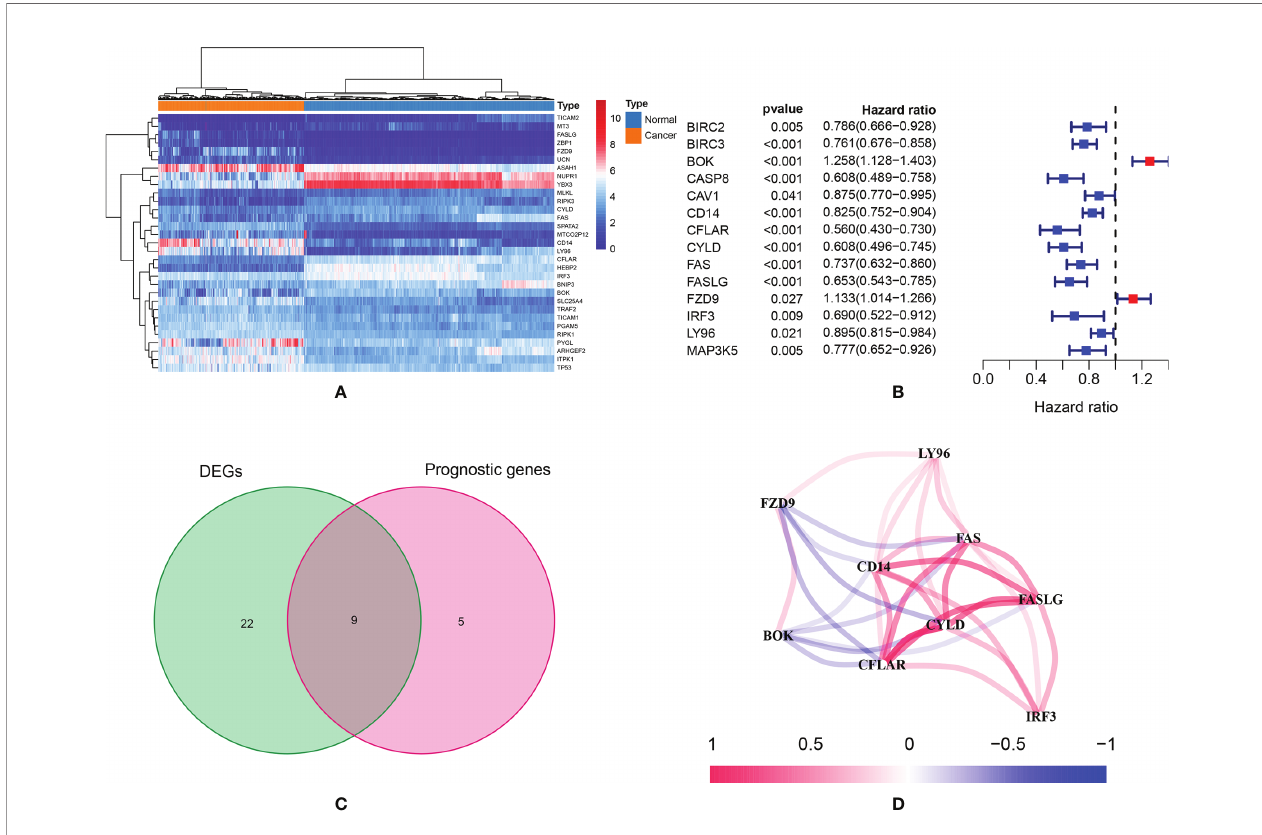
FIGURE 2 | (A) The heatmap of necroptosis-related genes which were differently expressed; (B) According to the results of univariate Cox regression analysis, a total of 14 genes were identi fi ed as prognostic genes; (C) Nine intersected genes were selected as target genes; (D) Correlation network of intersected